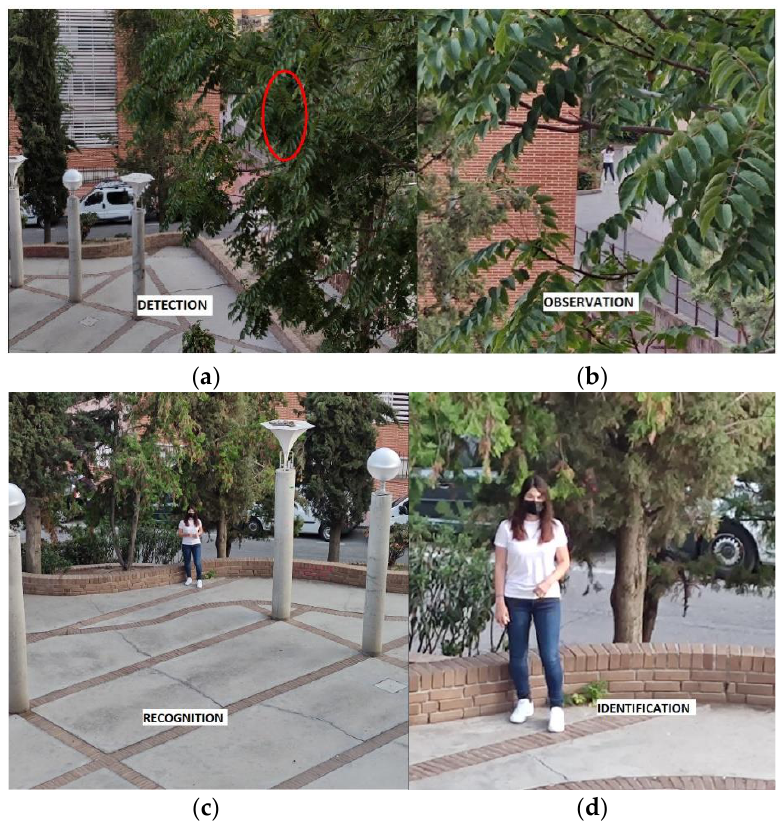
Figure 2. Example of DORI concept: ( a ) Detection, ( b ) Observation, ( c ) Recognition and ( d ) Identification.